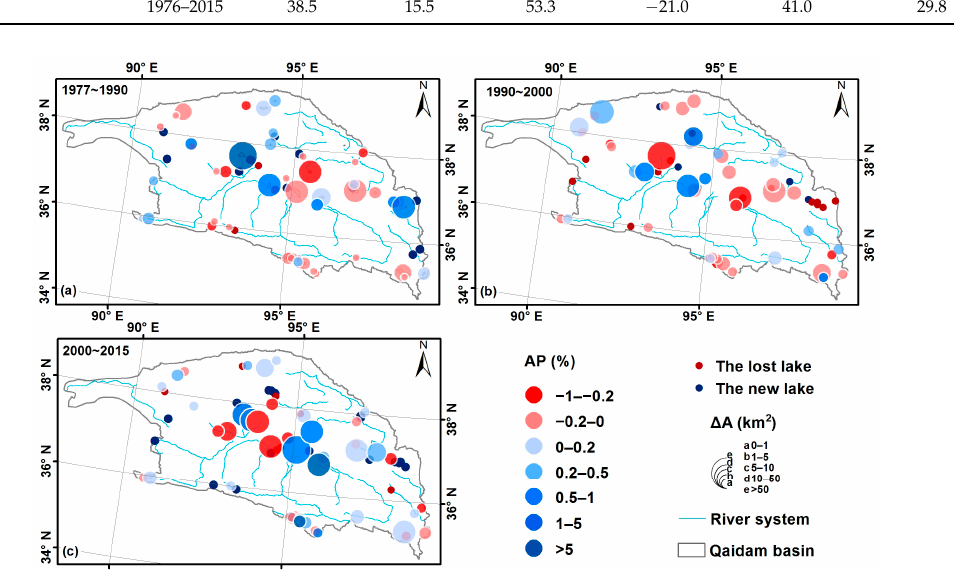
Figure 5. Spatial distribution of decadal lake changes in the Qaidam Basin (QB): 1977–1990 ( a ); 1990–2000 ( b ); and 2000–2015 ( c ).